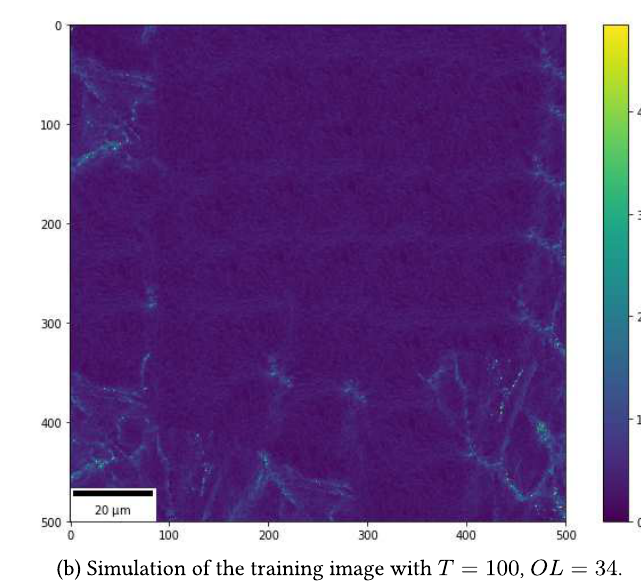
Fig. 9. Low quality simulation example – EMD = 0 . 26